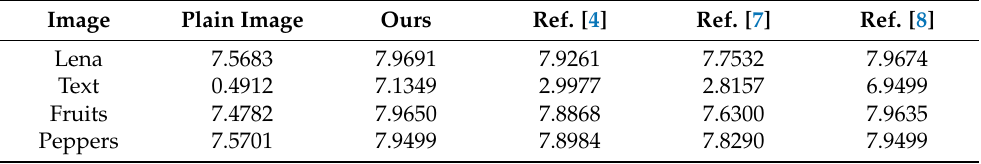
Table 3. Information entropy test results of scrambled intermediate cipher image. Image